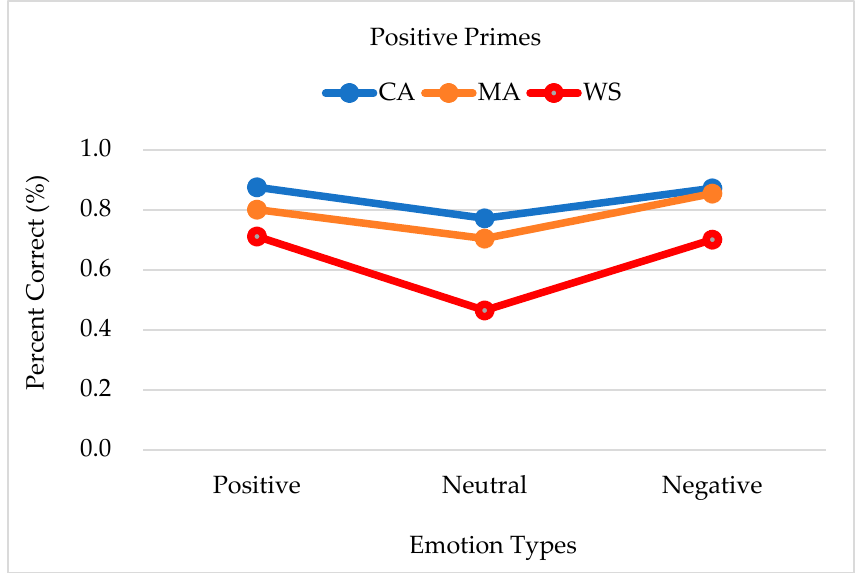
Figure 1. Accuracy of the responses to positive primes by each emotion target type and group. Note. CA, chronological age-matched controls; MA, mental age-matched controls; WS, participants with Williams syndrome.